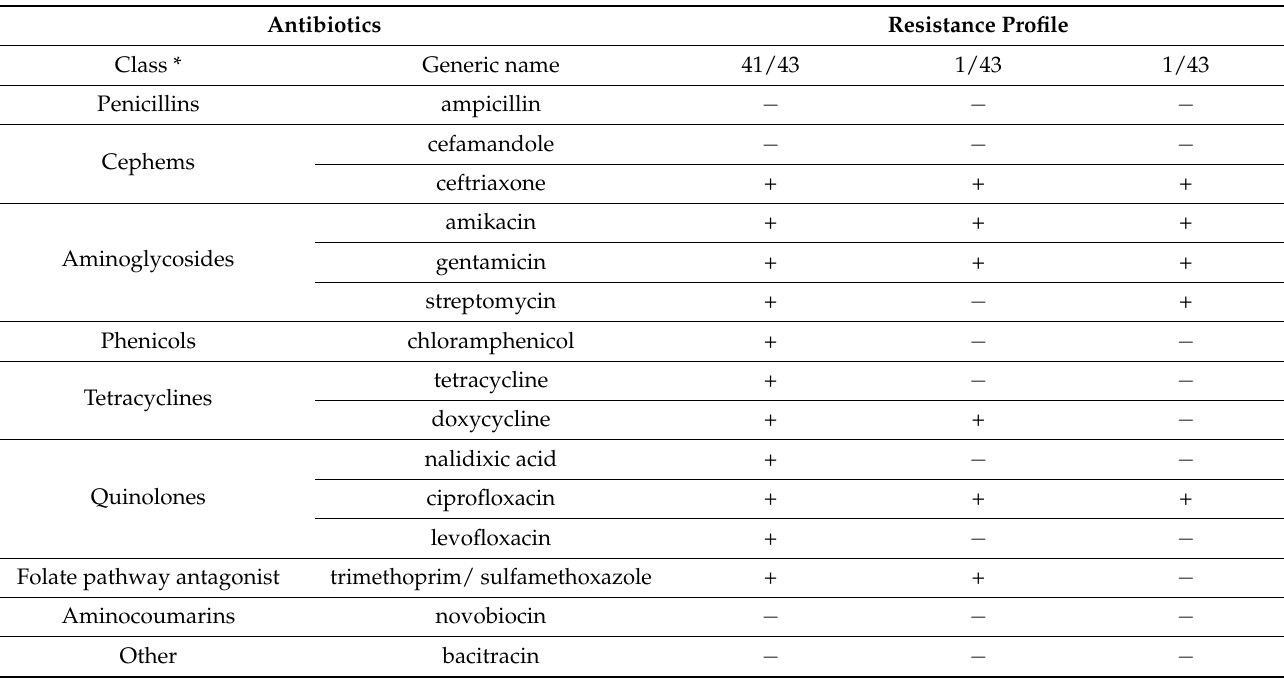
Table 1. Antimicrobial susceptibility of Y. enterocolitica strains isolated from the slaughtered pigs. Three profiles of resistance to the selected antibiotics were